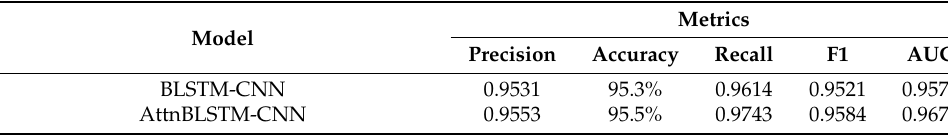
Table 2. Experimental results of AttnBiLSTM-CNN and